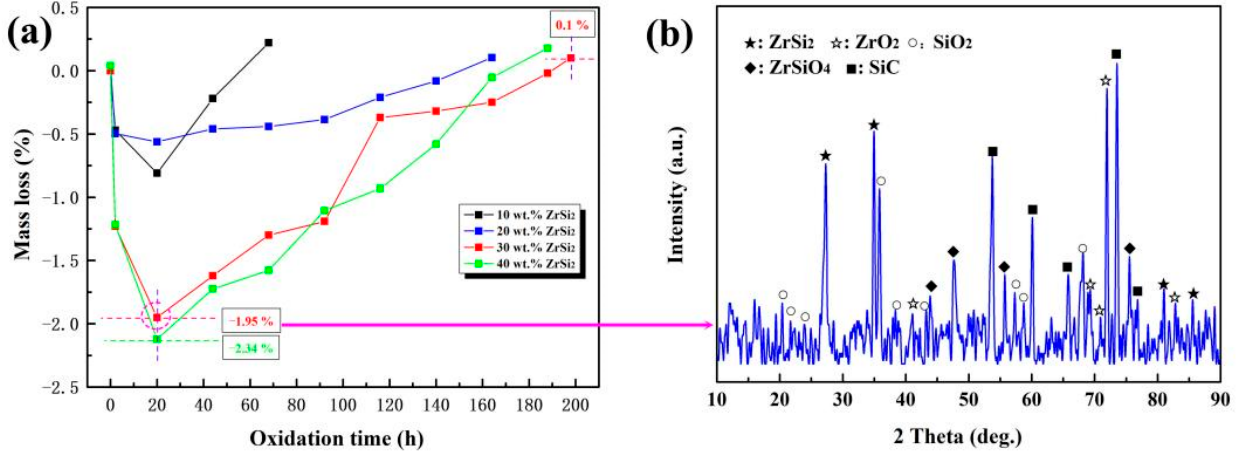
Figure 7. ( a ) Isothermal oxidation curves of the samples with different ZrSi 2 content at 1500 °C; ( b ) the XRD analysis of the sample with 30 wt.% ZrSi 2 in the ZrSi 2 -SiC outer coating after 21 h oxidation at 1500 °C.